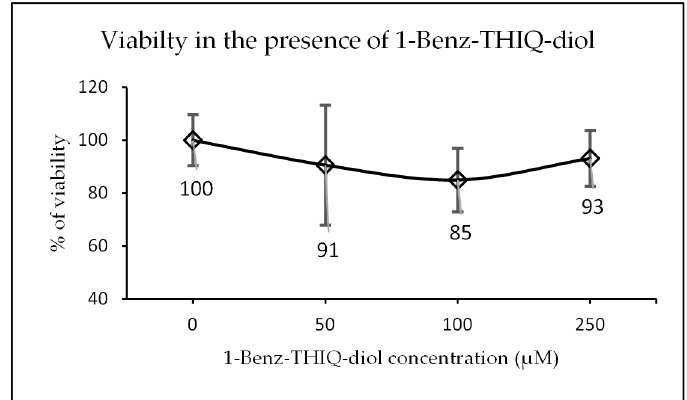
Figure 15. Viability after 24 h exposure to different concentrations of 1-Benz-THIQ-diol, data from four biologically independent experiments performed with three technical replicates (resazurin viability test; mean ± SD) (N = 12). There is no significant difference between concentrations (ANOVA; p = 0.150).